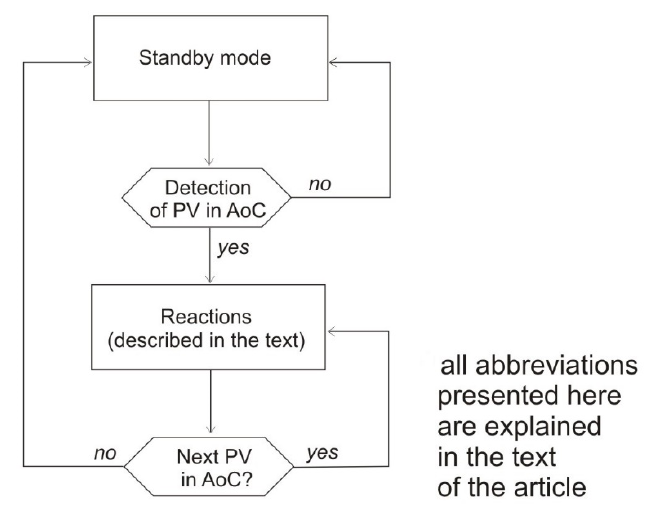
Figure 7. The algorithm for case 3: Vicinity of the railroad crossing .